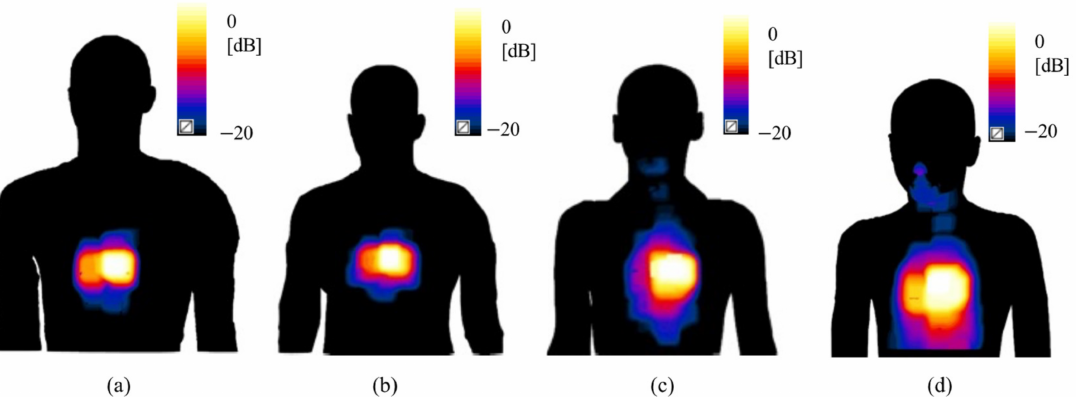
Figure 5. SAR 10g distribution on the skin when the antenna is positioned on the trunk of the simulated human models: ( a ) Duke, ( b ) Ella, ( c ) Louis, and ( d ) Billie. All values are represented with respect to the maximum SAR 10g value found in each